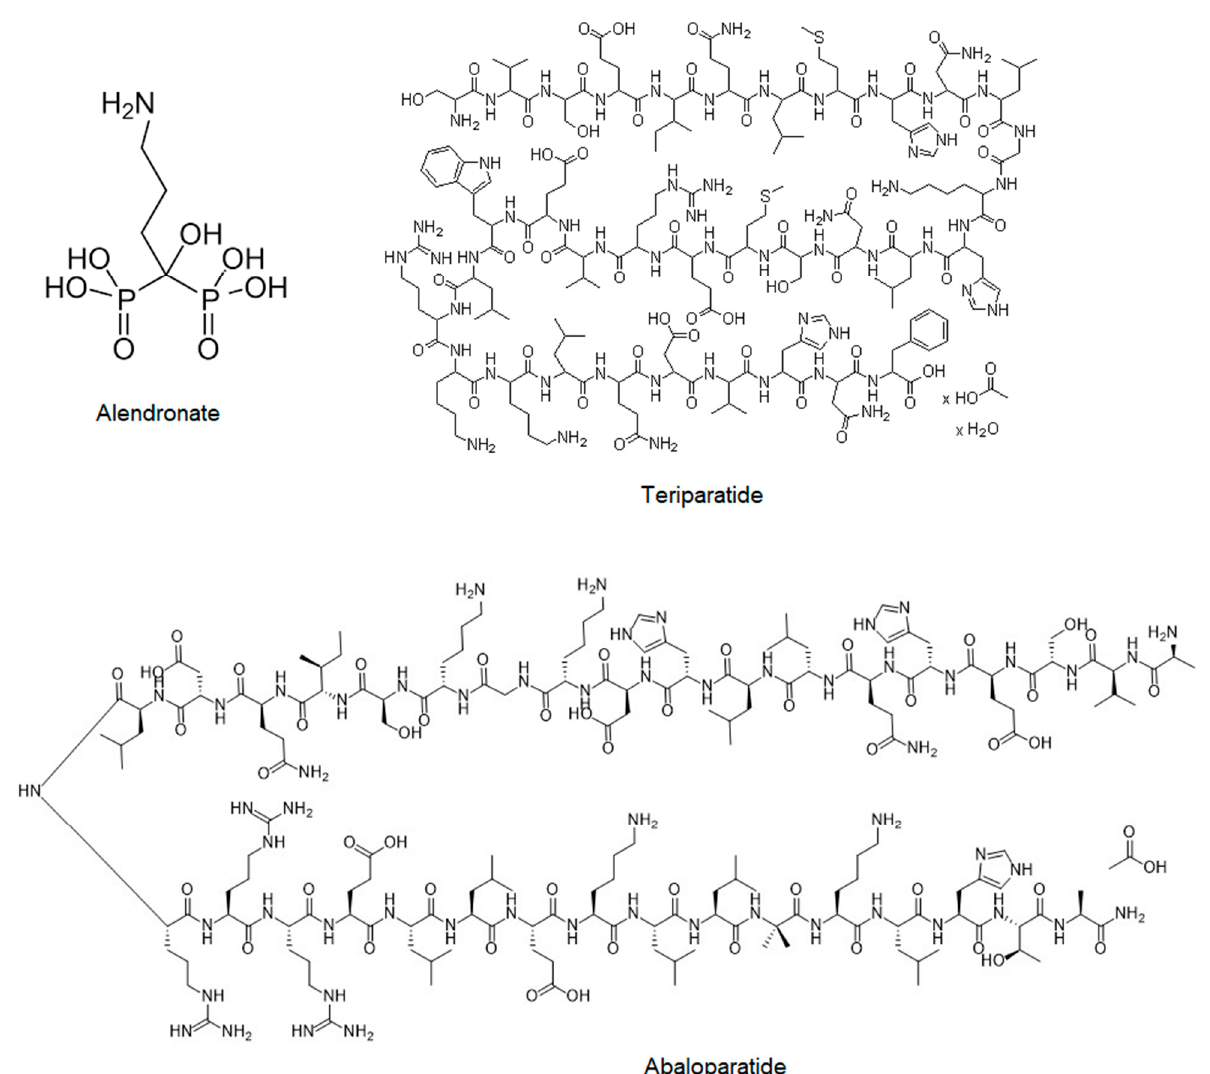
Figure 2. Structure of drugs used in the prevention of osteoporosis.